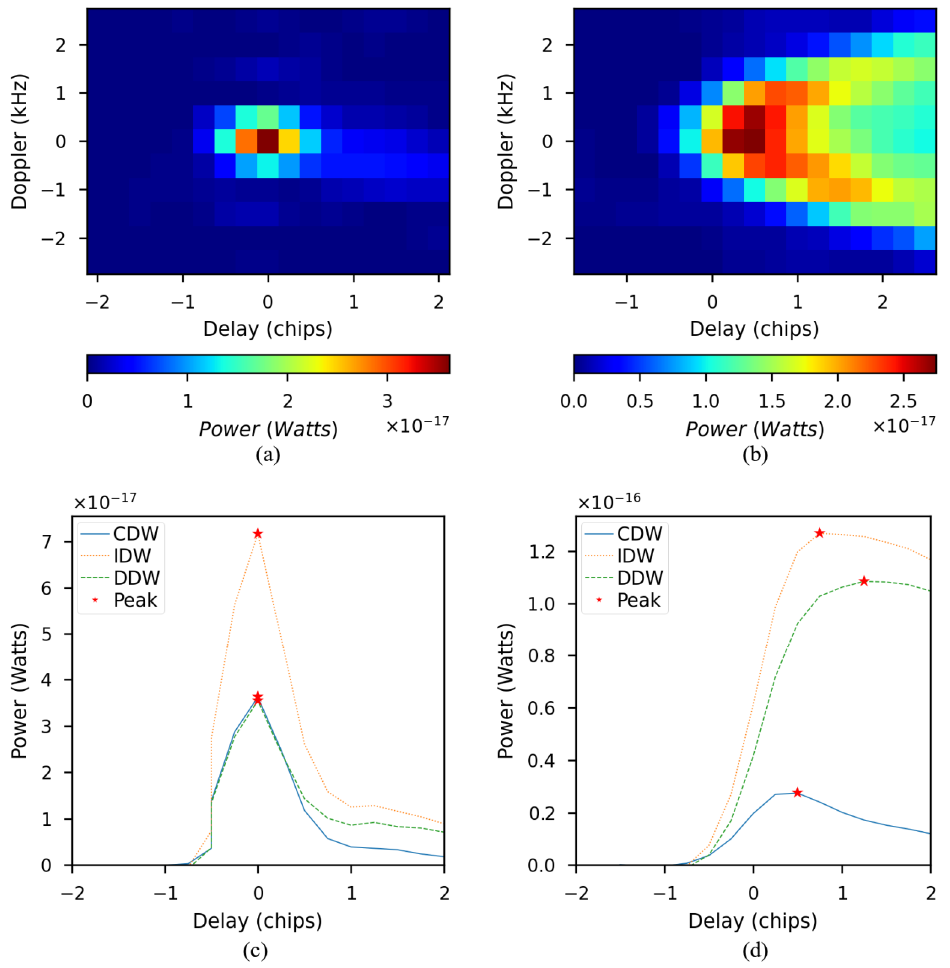
Figure 1. Typical scattering-power delay-Doppler map (DDM) and delay waveforms over the land surface ( a , c ) and ocean surface ( b , d